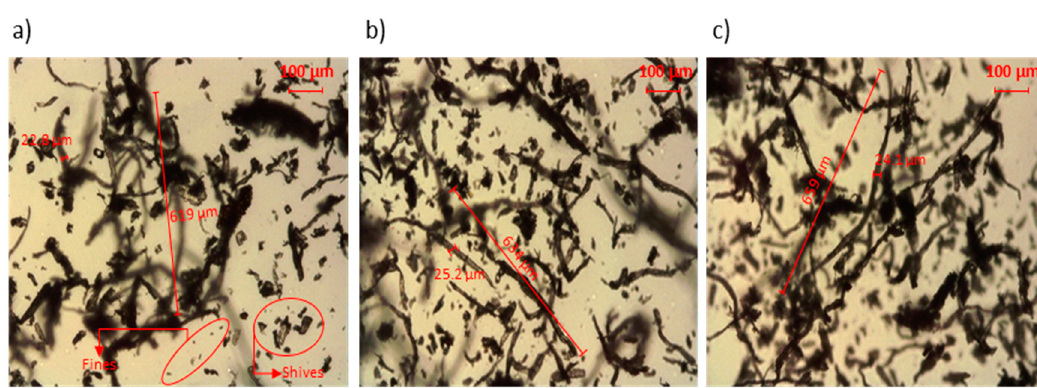
Figure 4. Light microscopy images of hemp core fibers treated at ( a ): 5 wt % NaOH, ( b ): 7.5 wt % NaOH and ( c ): 10 wt % NaOH.